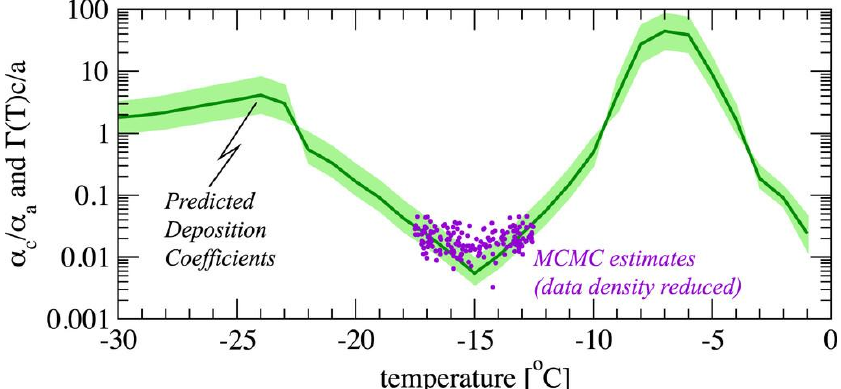
Figure 7. The green line shows the ratio of deposition coefficients for the ice crystal c and a axes as a function of temperature, with the green shading indicating the uncertainty, extracted from wind tunnel measurements (from [129]). The purple dots show the inherent growth ratio ( Γ ) times the ice crystal axis ratio obtained from Markov chain Monte Carlo simulations and X-band polarimetric radar observations (plotted with reduced data density, for clarity). Reprinted/adapted with permission from [77]. 2021, American Meteorological Society.